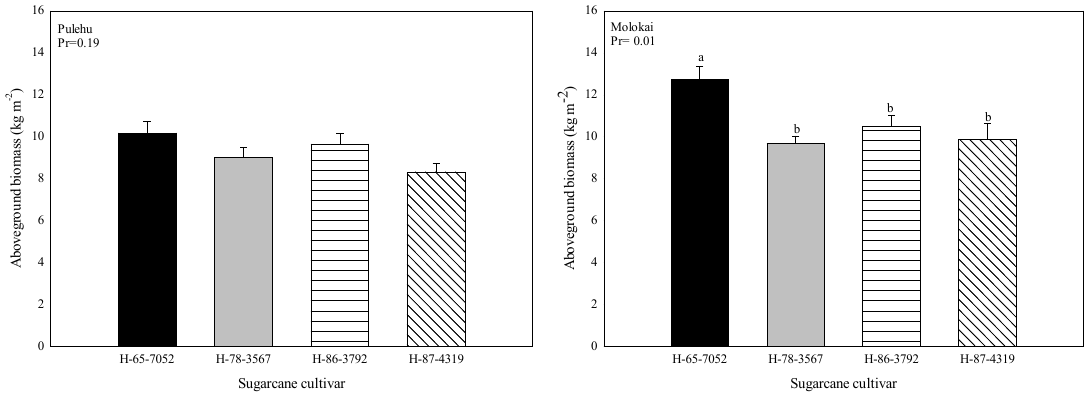
Figure 7. Aboveground biomass from sugarcane cultivars plant samples collected less than two weeks prior to harvest date. Means from sugarcane cultivars bars followed by the same letter or no letters are not significantly different Tukey’s test at Pr < 0.05.